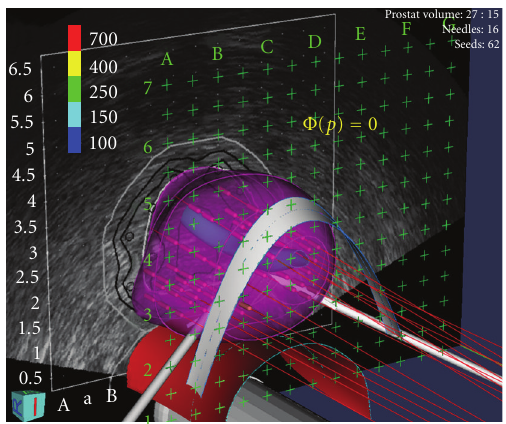
Figure 4: 3D representation of the contact surface (prostate gland) which is variable and it is di ff erent for each case. Mathematical equation of contact surface is calculated using Euclidian robotic system